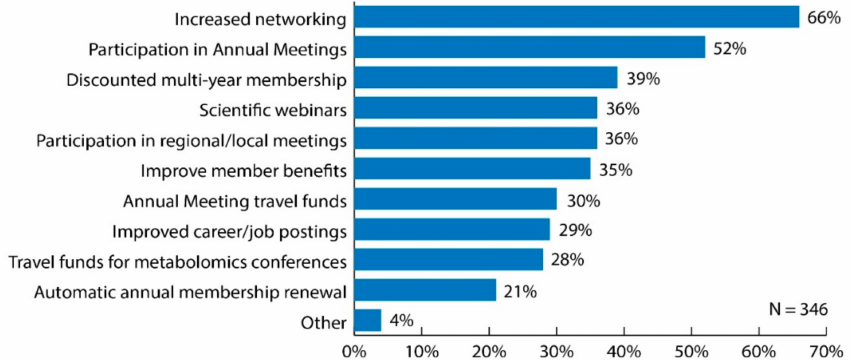
Figure 4. Bar graph of survey results for question: “What are the best strategies for the Metabolomics Society to maintain members? Choose all that apply.” Original data used to create the figure can be found in the supplementary information under question number 19.